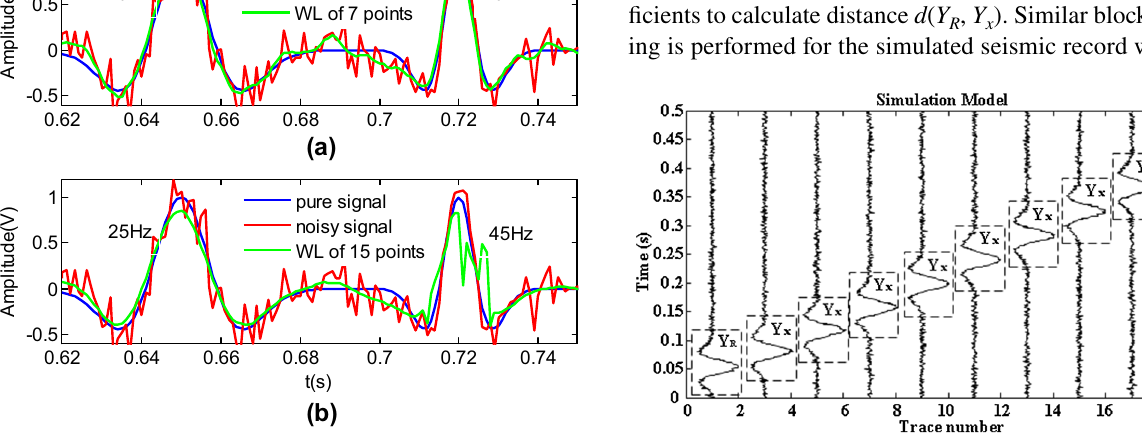
Fig. 1 a Result of WL of 7 points. b Result of WL of 15 points Fig. 2 Diagram of block